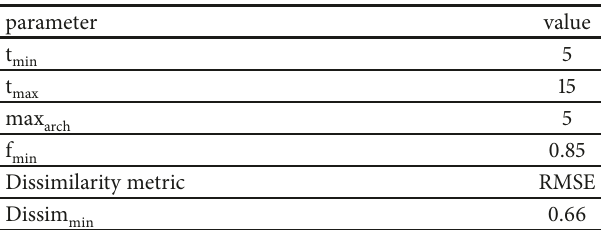
Table 6: Experimental parameters.